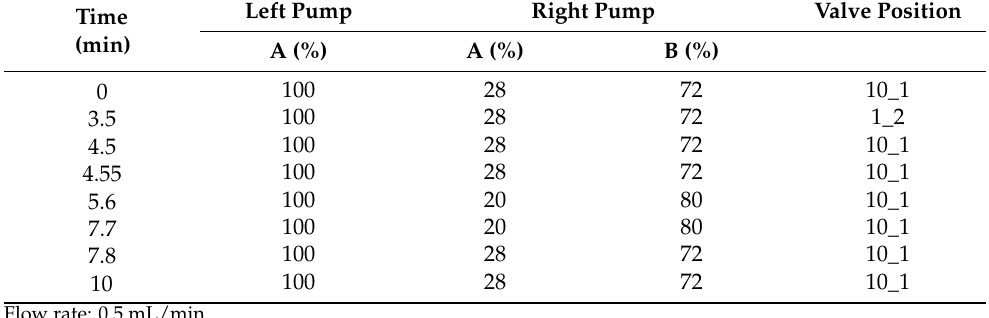
Flow rate: 0.5 mL/min.